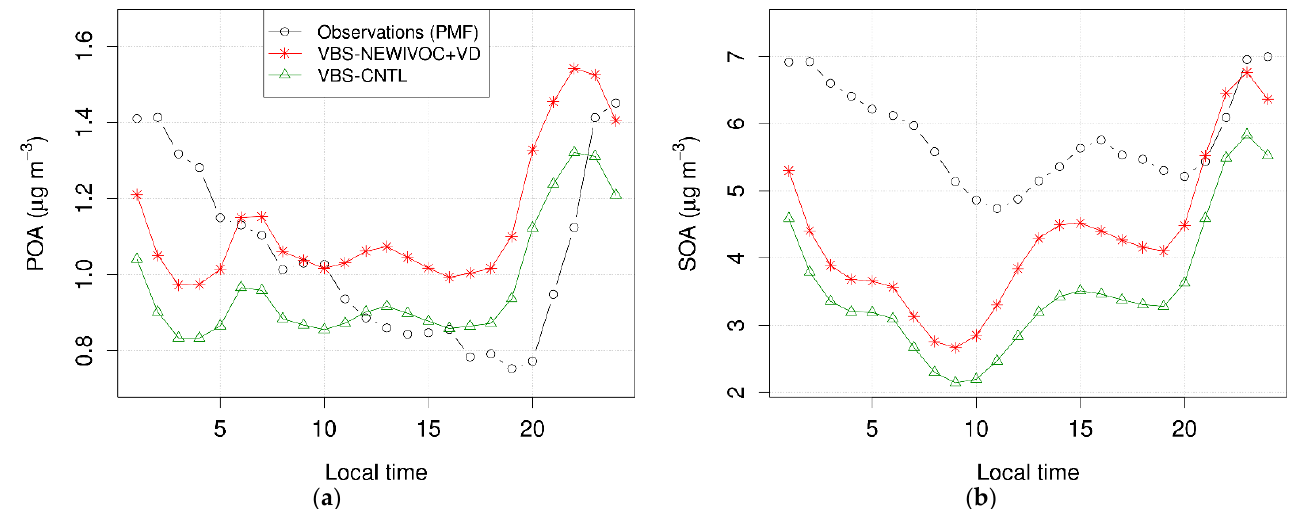
Figure 7. Mean diurnal profile of observed (PMF results, black) and modeled POA ( a ) and SOA ( b ) concentrations at the Ispra site for the quarter period of May – July 2013: VBS base simulation (VBS-CNTL, green) and VBS scheme with new parameterizations for IVOC emissions and revised volatility distribution (VBS-NEWIVOC+VD, red).